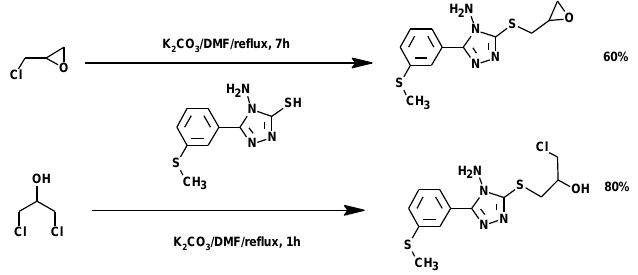
Figure 25. Synthesis of triazole-thioglycoside from ECH and DCH.